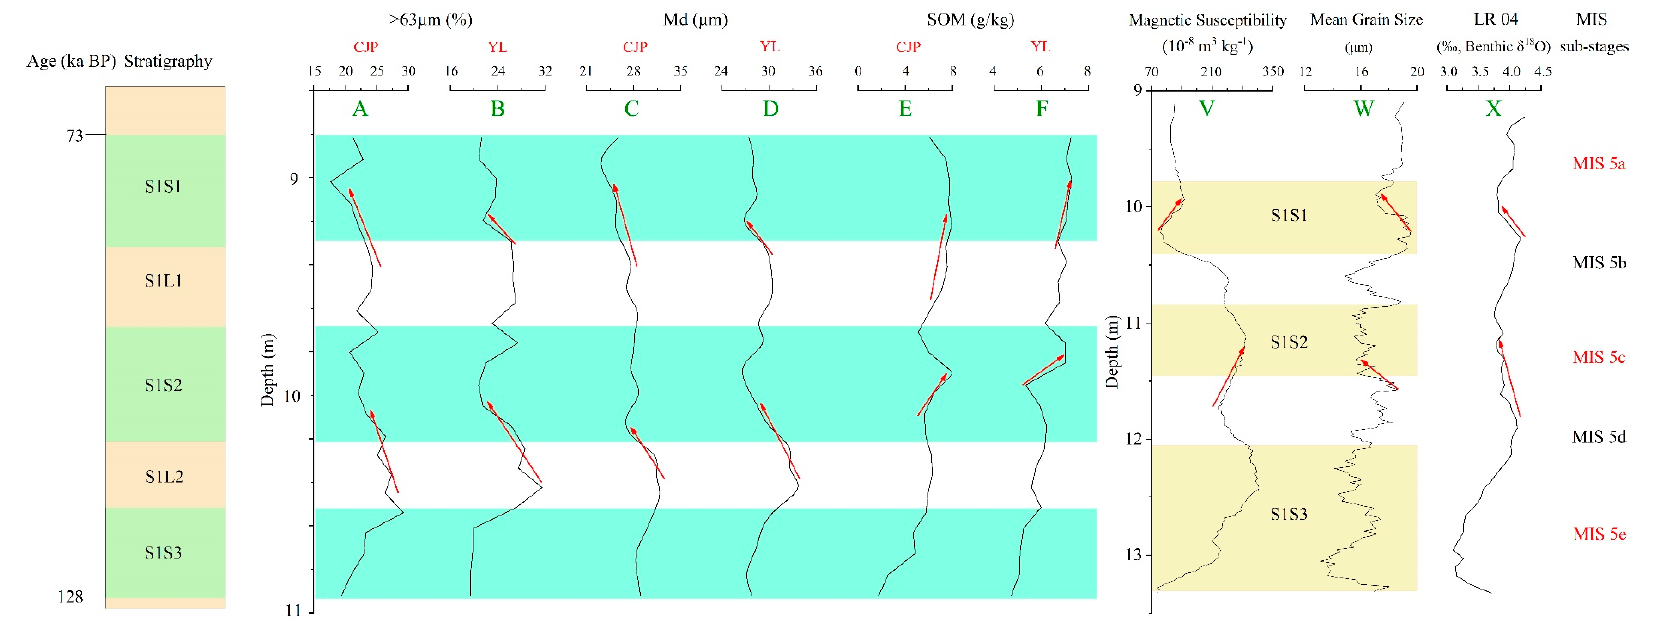
Figure 3. Basic properties of S1 profile as compared with the LR04 curve (X) [36] and the magnetic susceptibility and mean grain size curves of Weinan profile (V and W) [28]. In this figure, SOM is soil organic matter, MIS is Marine Isotope Stage, LR 04 is a 5.3-Ma stack of benthic δ 18 O records from 57 globally distributed sites published by Lisiecki & Raymo in 2005. The red arrows indicate the warming trend revealed by the selected parameters and marine records.